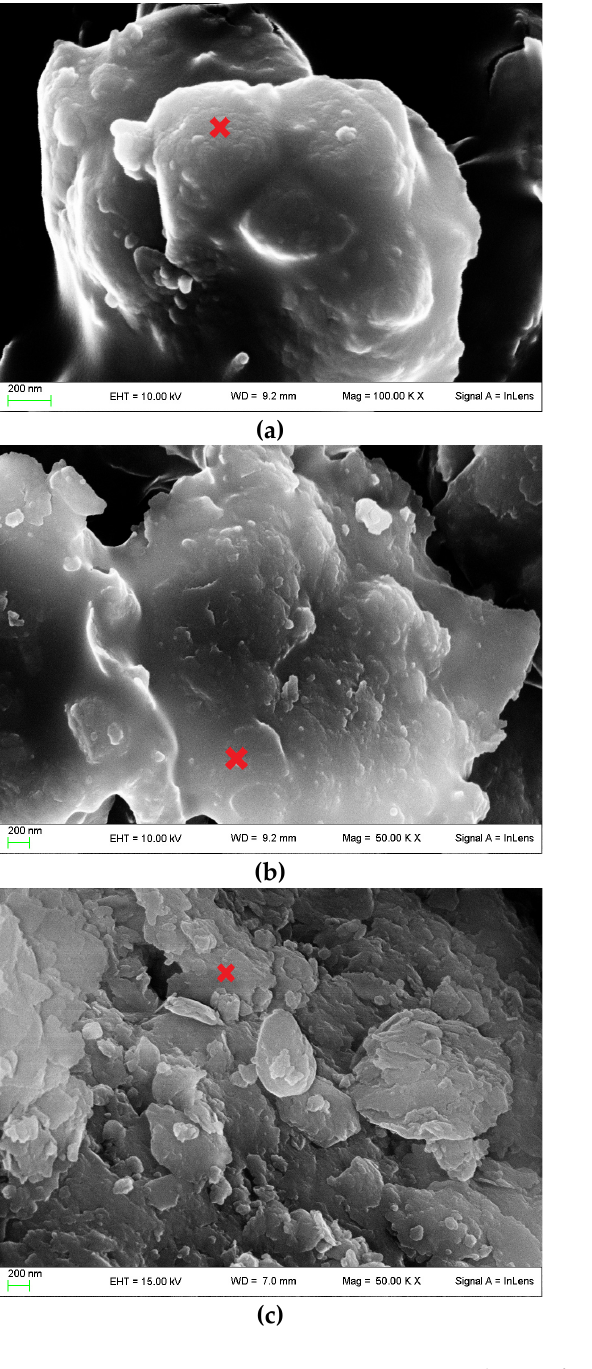
Figure 8. Fe-SEM photos of treated PR/PeA/GEOS ( a ), PR/OlA/GEOS ( b ), and PR/GrA/GEOS ( c ) after 28 days of curing. For each sample, the chemical analyses (EDS) are reported on the right. Red crosses indicate the points at which the analyses were carried out. The images show the lamellar structures coated by amorphous gels.